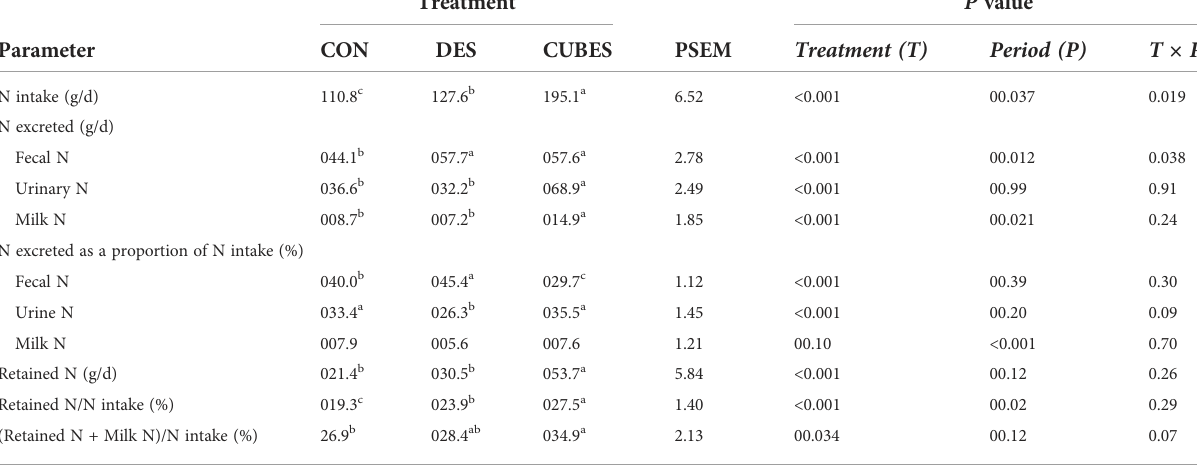
TABLE 7 Mean daily nitrogen (N) intake, N excretion and N retention of crossbred cows ( n =12) fed on a control diet (CON) consisting mainly of Urochloa brizantha hay alone or supplemented with either Desmodium intortum hay (DES) or a commercial dairy supplement (CUBES) over three periods with the measurements lasting for 7 d.